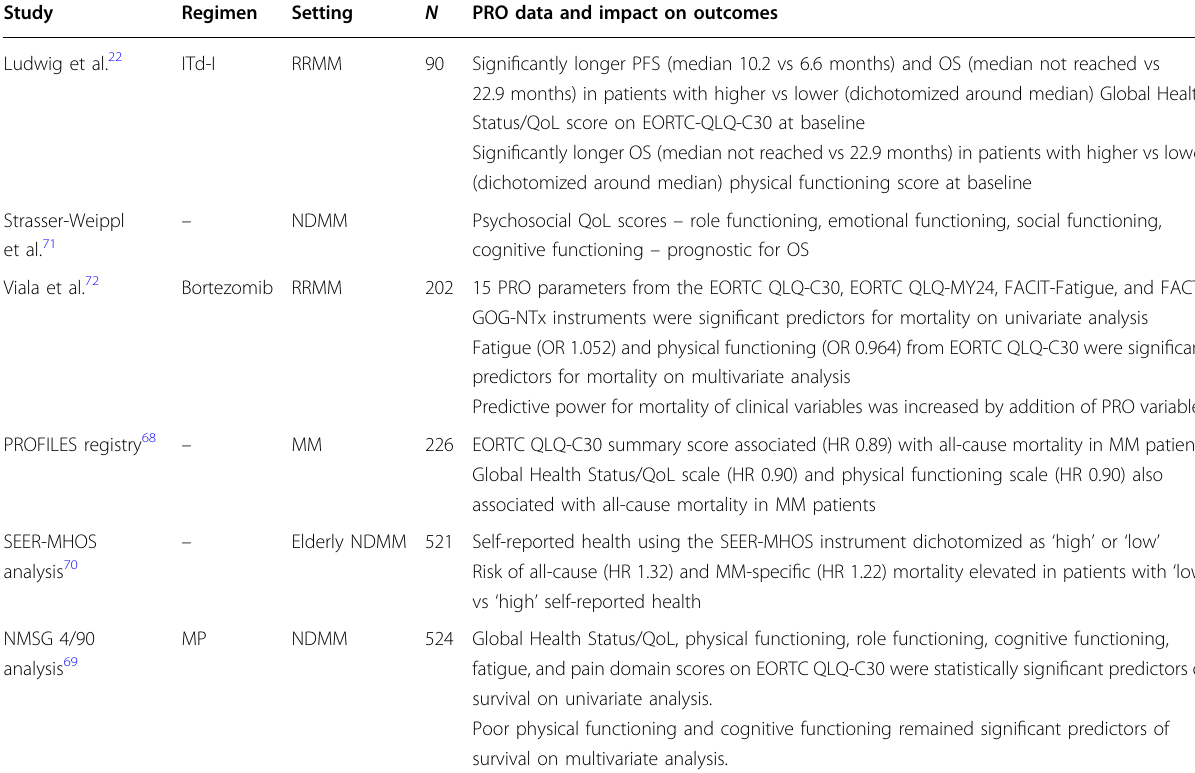
Table 3 The importance of PRO data in relation to outcomes in MM.